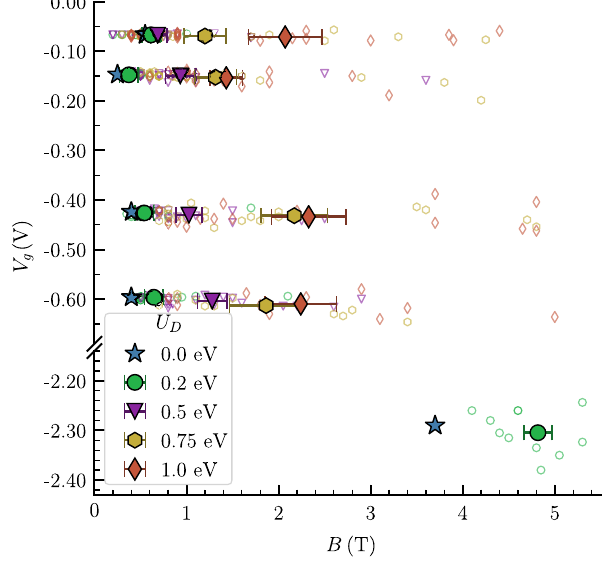
FIG. 16. Topological phase phase diagram in the presence of disorder. Plotted are the positions of the local minima B (cid:2) of c critical magnetic fields in B , V plane. Empty dots corresponds to g separate disorder realizations, filled symbols are disorder aver- ages with the corresponding error bars. Increasing disorder strength leads to larger critical